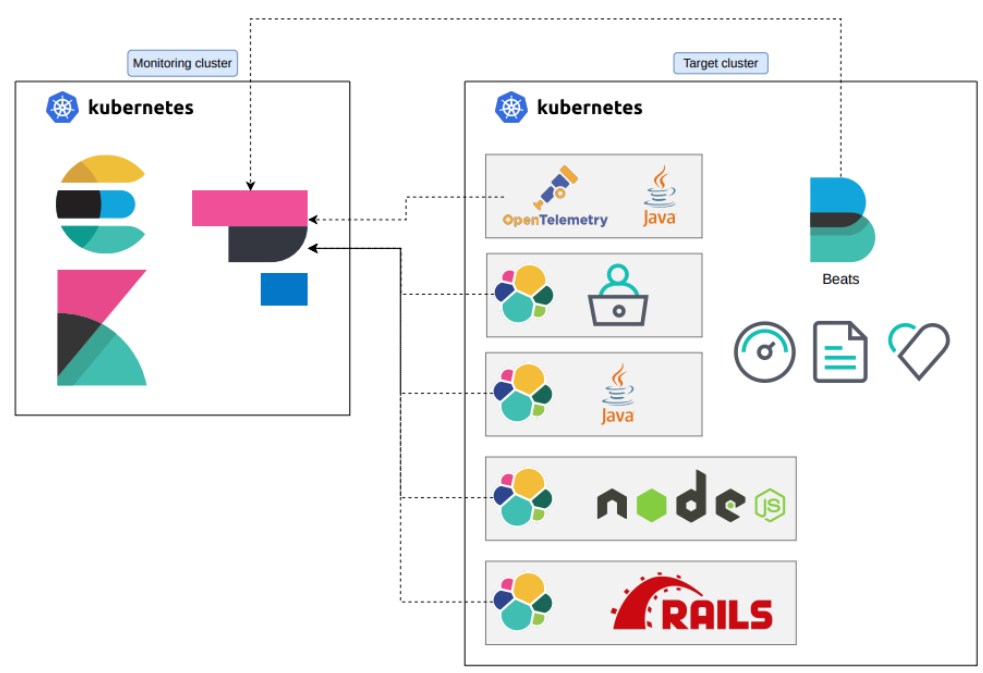
Figure 3. High-level architectural view of the proposed solution with the target cluster set up for the